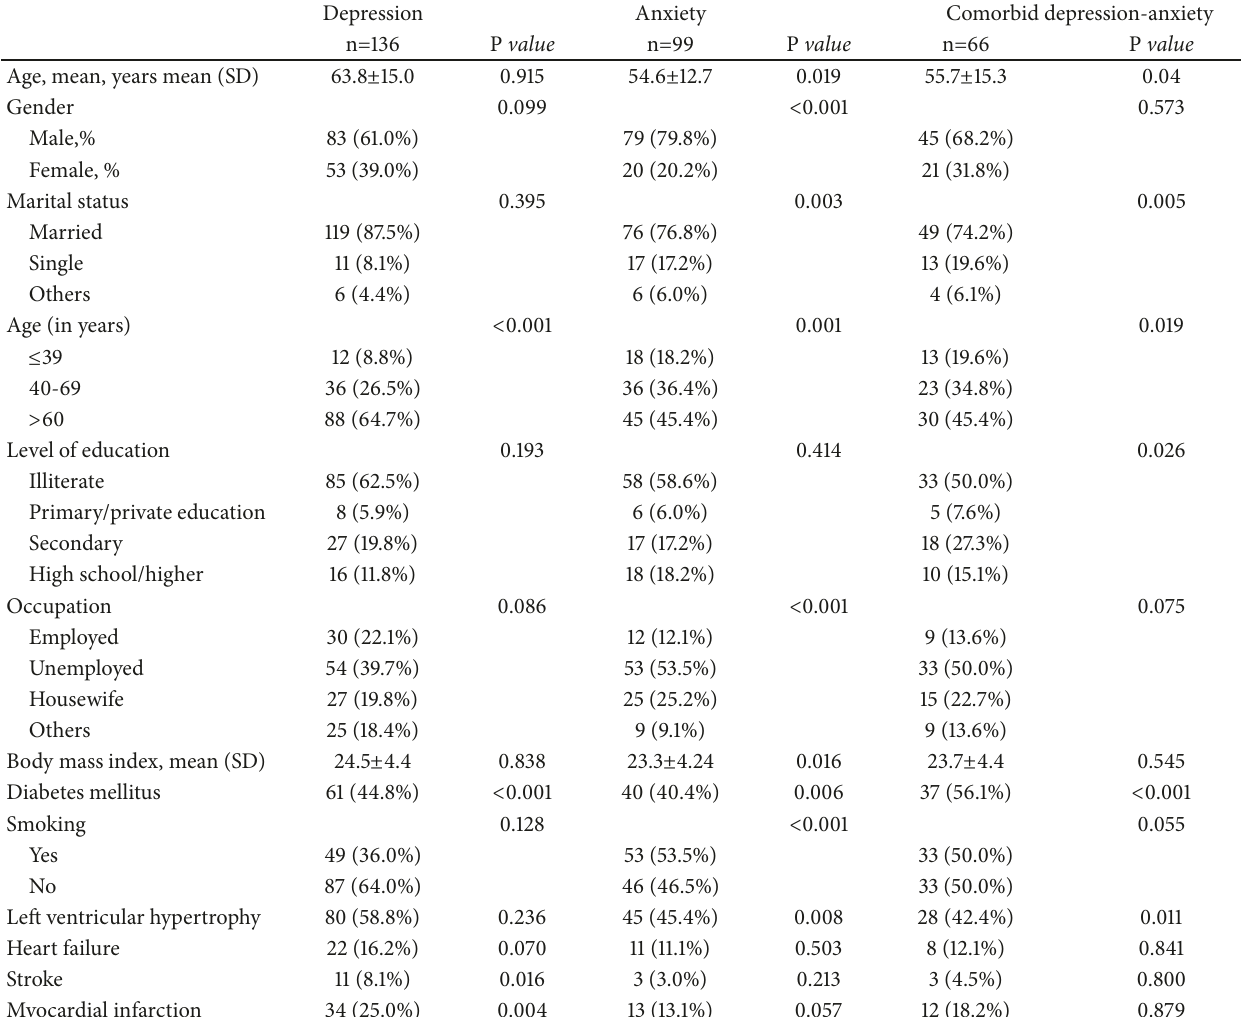
Table 2: Association between sociodemographic and clinical characteristics with depression, anxiety, and comorbid anxiety-depression among hypertensive